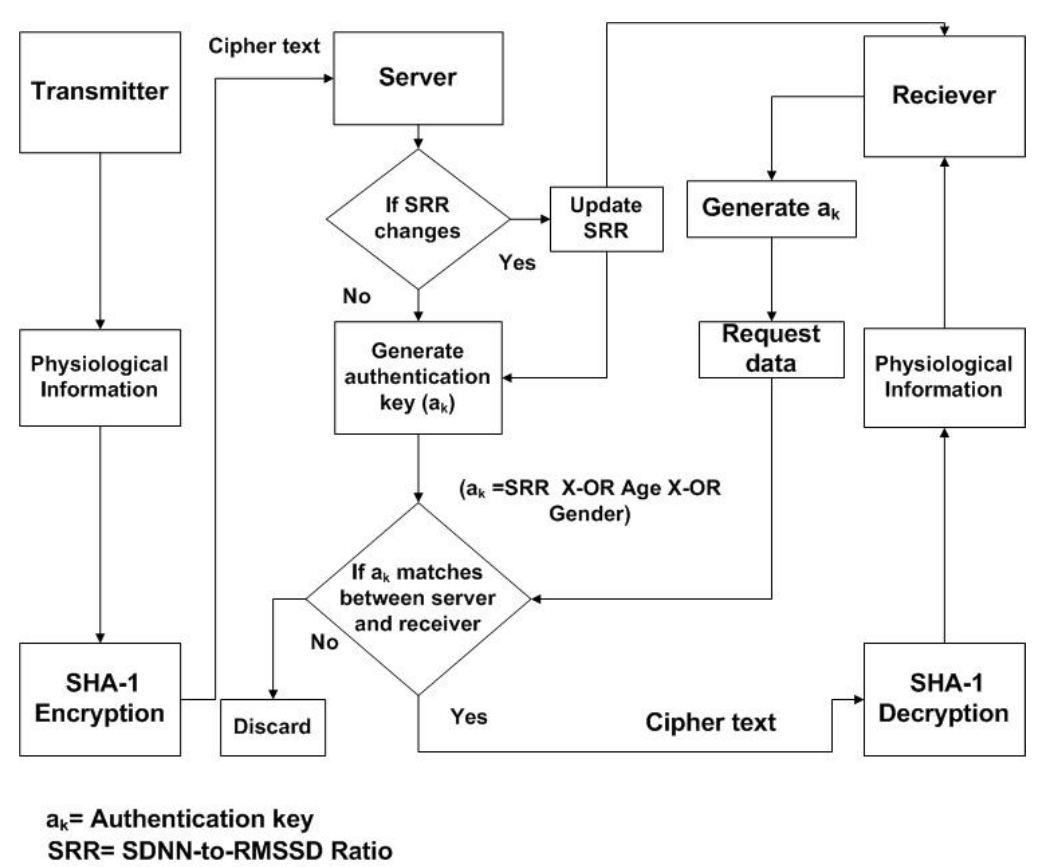
Figure 4. The block diagram of communication model for Body Sensor Networks (BSNs) using proposed authentication